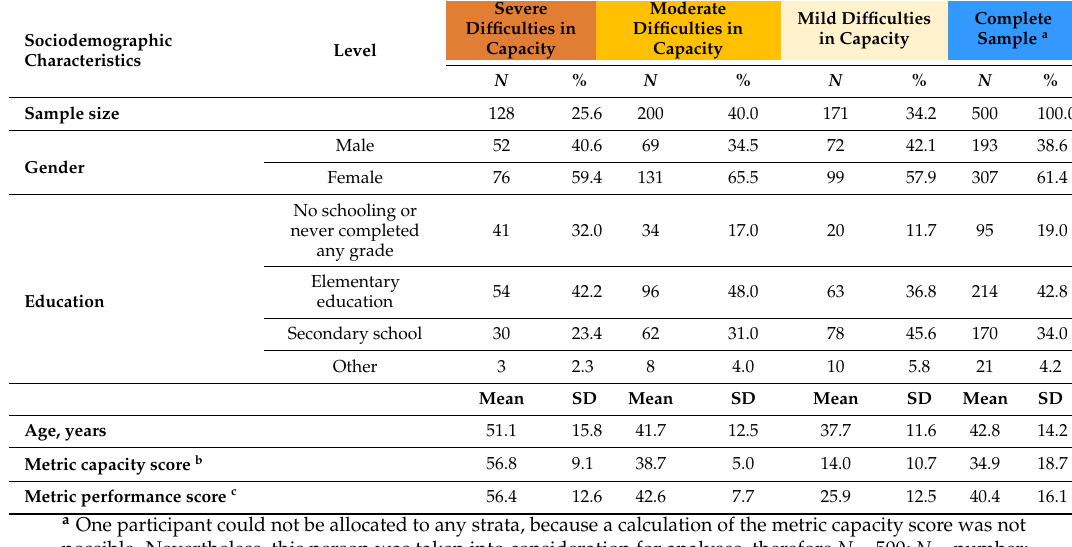
Table 1. Sociodemographic characteristics of the study population ( N =